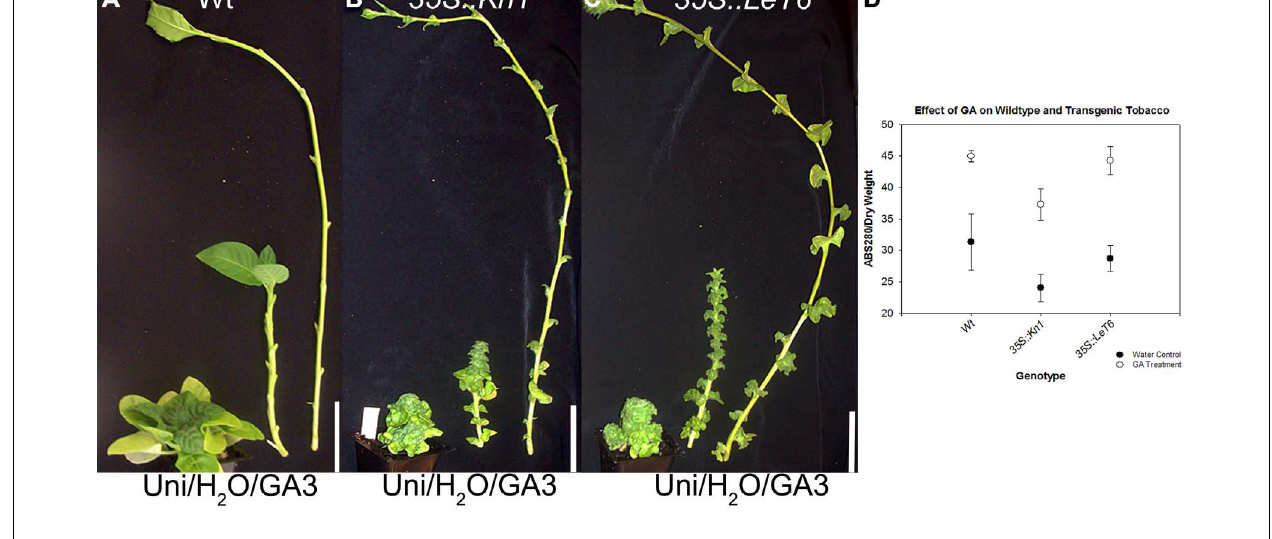
FIGURE 3 | Effects of gibberellic acid (GA3) and GA biosynthesis inhibitor uniconazole (Uni; left), water (H 2 O) control (middle), and gibberellic acid3 (GA3; right) on (A) wild-type (Wt), (B) 35S::Kn1 , and (C)